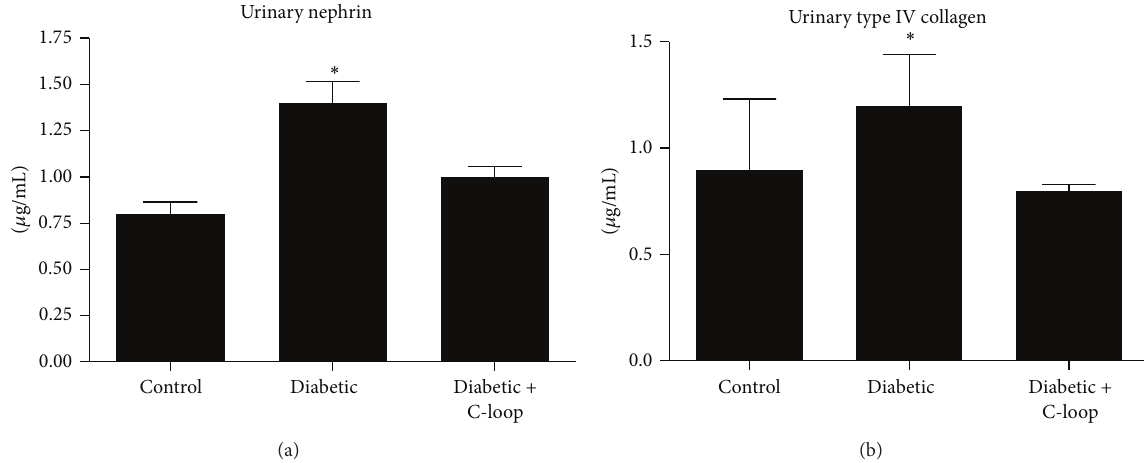
Figure 3: Urinary nephrin (a) and type IV collagen (b) were measured on spot urine samples obtained at the end of 12 weeks of treatment. The results are shown as 𝜇 g/mg creatinine (mean ± SEM). ∗ 𝑃 < 0.05 when the vehicle-treated diabetic animals are compared to the diabetic animals treated with the anti-C-loop antibody. ∗ 𝑃 < 0.05 when the control nondiabetic animals are compared to the vehicle-treated diabetic animals.